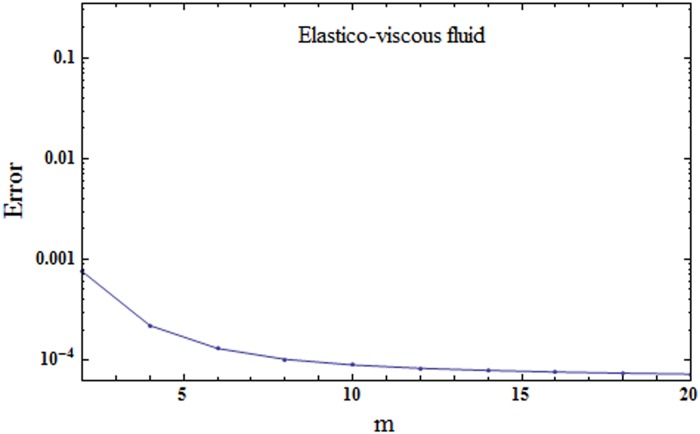
Total residual error for elastico-viscous fluid.